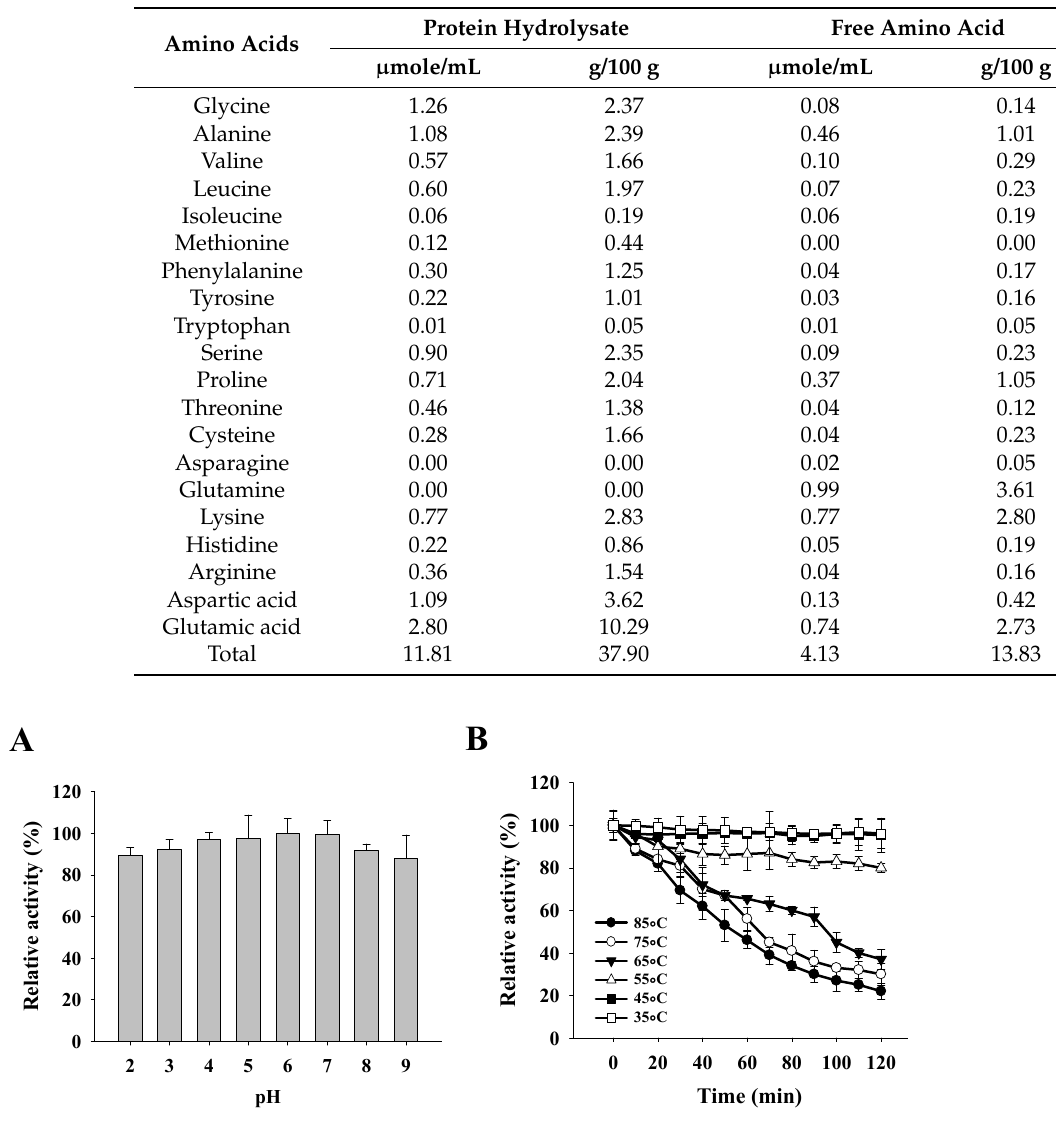
Figure 1. pH and thermal stabilities of the hypoglycemic activity of S. pastorianus extract using differentiated 3T3-L1 cell assay model. ( A ) Relative activity of S. pastorianus extract on facilitating glucose uptake after heat-treatment at various temperatures for 0–120 min. ( B ) Relative activity of S. pastorianus extract on facilitating glucose uptake after exposure to solutions with different pH for 2 h.